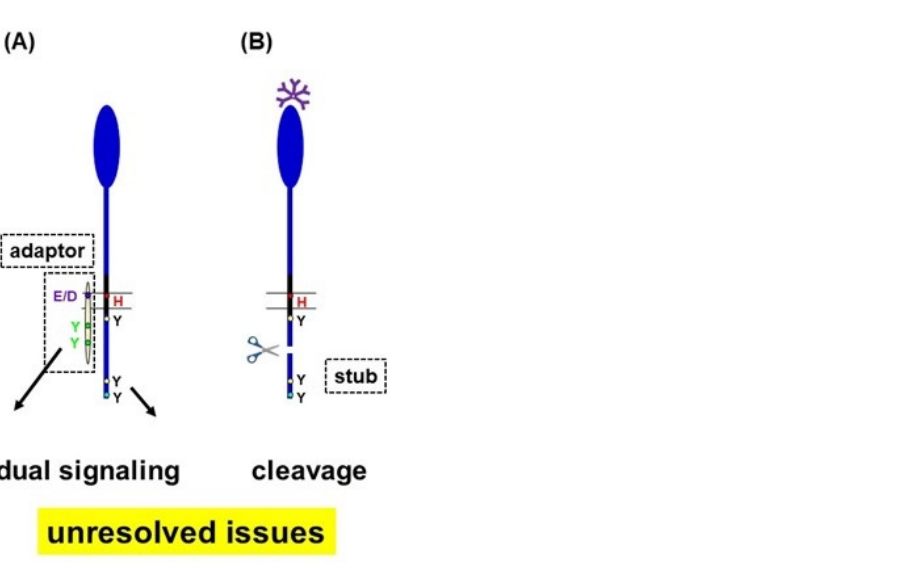
Figure 3. Unresolved issues of Fc µ R. ( A ) Existence of a potential adaptor protein non-covalently associating with Fc µ R via the His 253 in its TM. ( B ) Potential cleavage at the C-terminal tail of Fc µ R, after receptor ligation, creating the stub containing the ITT motif.